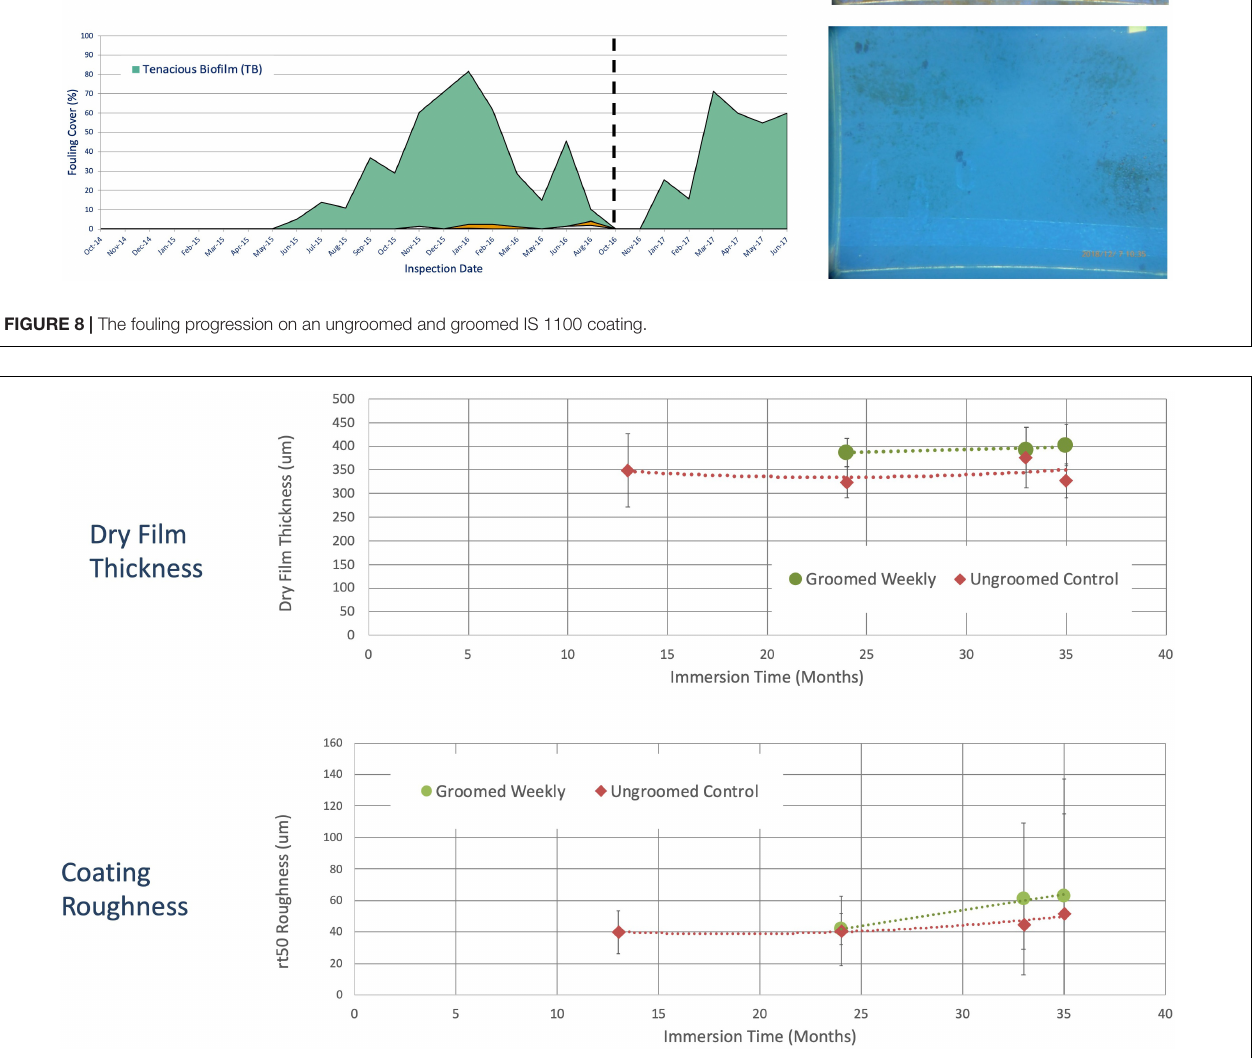
FIGURE 9 | Dry film thickness and roughness measurements on groomed and ungroomed IS1100 coating.